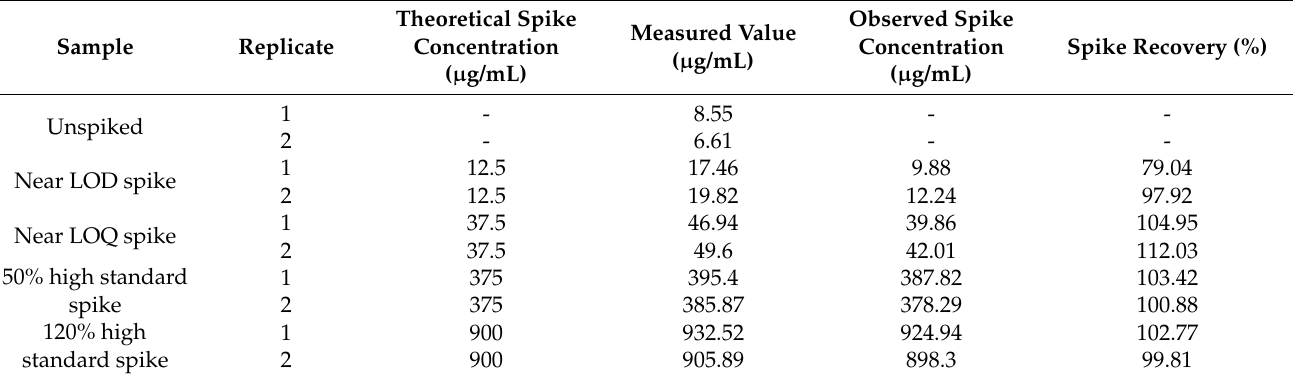
Table 6. Total fluorine pre-extraction spike recovery